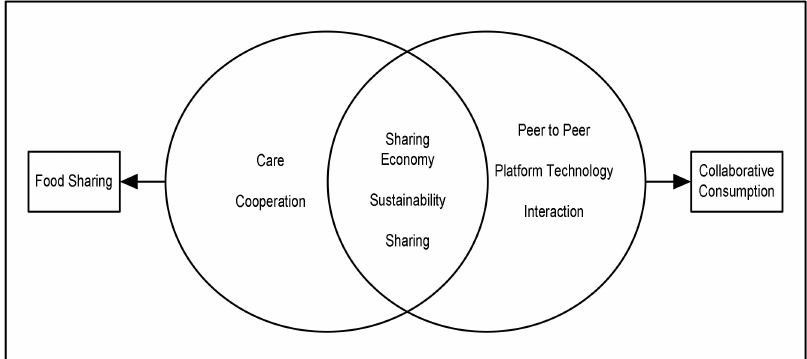
Figure 4. The Characteristics of food sharing and collaborative